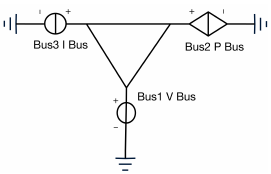
Figure 12. Complete circuit of the simple power